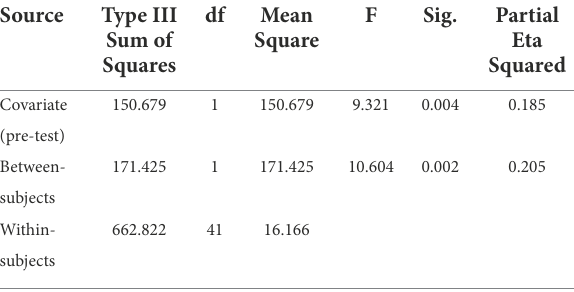
TABLE 3 ANCOVA results for listening performance.